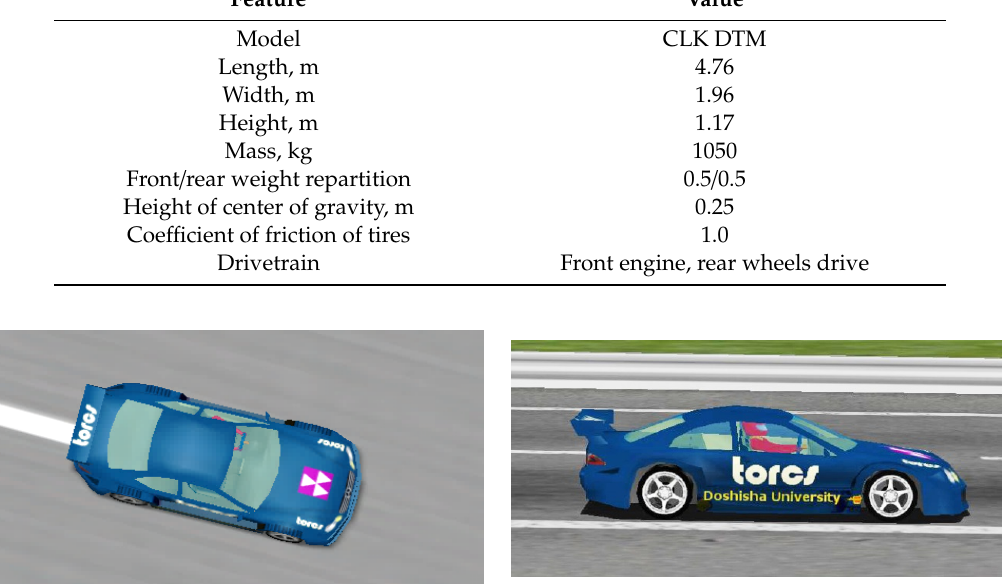
Figure 1. Snapshots of the simulated car.